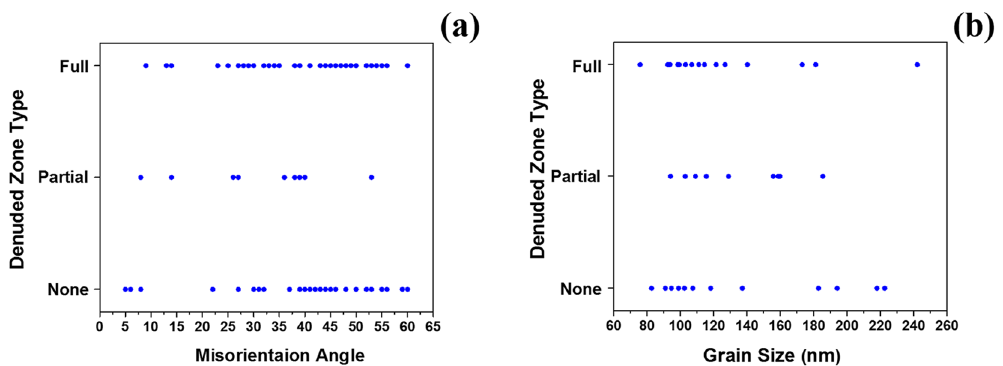
Figure 5. ( a ) and ( b ) Loop denuded zone type vs size grain size and misorientation angle